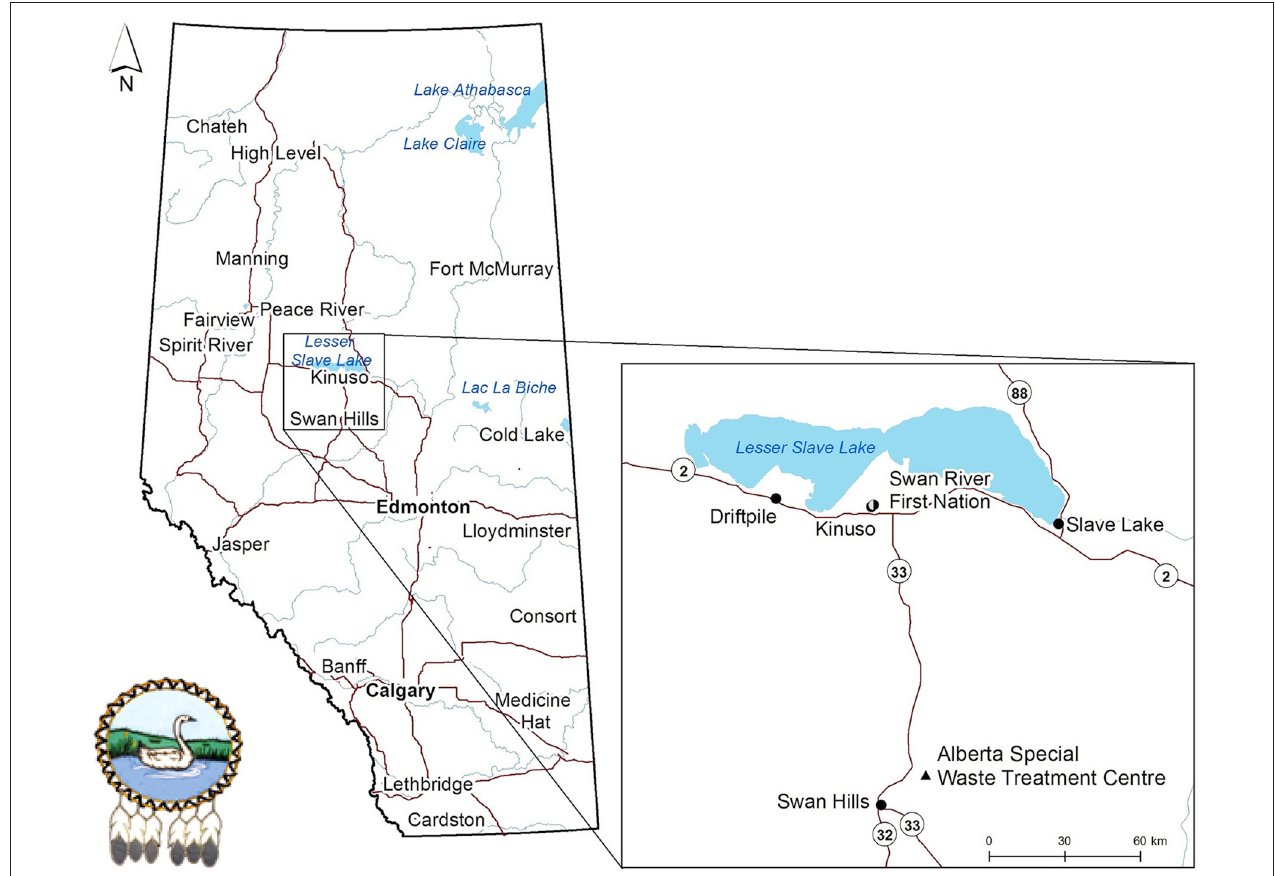
FIGURE 1 | Map of Alberta showing the study